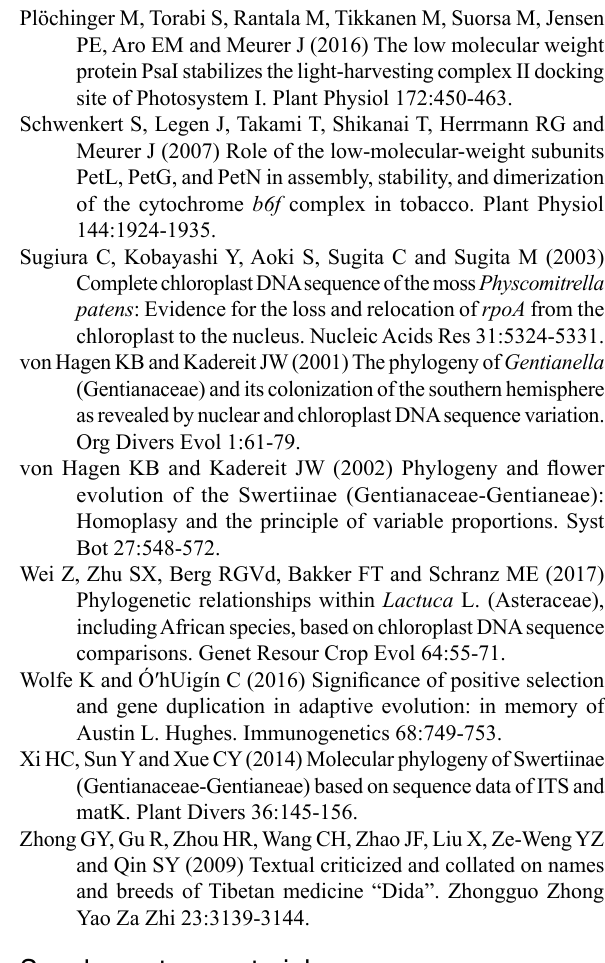
Figure S1 – Gene maps of S. dichotoma chloroplast genome. Figure S2 – Gene maps of S. dilatata chloroplast genome. Figure S3 – Gene maps of S. diluta chloroplast genome. Figure S4 – Gene maps of S. erythrosticta chloroplast genome. Figure S5 – Gene maps of S. franchetiana chloroplast genome. Figure S6 – Gene maps of S. mussotii chloroplast genome. Figure S7 – Gene maps of S. przewalskii chloroplast genome. Figure S8 – Gene maps of S. tetraptera chloroplast genome. Figure S9 – Gene maps of S. wolfgangiana chloroplast genome. Figure S10 – The alignment of chloroplast genomes for 15 Swertia species and four related species. S. wolfgangiana was used as a reference. Figure S11 – Non-synonymous/synonymous rate ratios of the protein coding genes from the chloroplast genomes of 15 Swertia